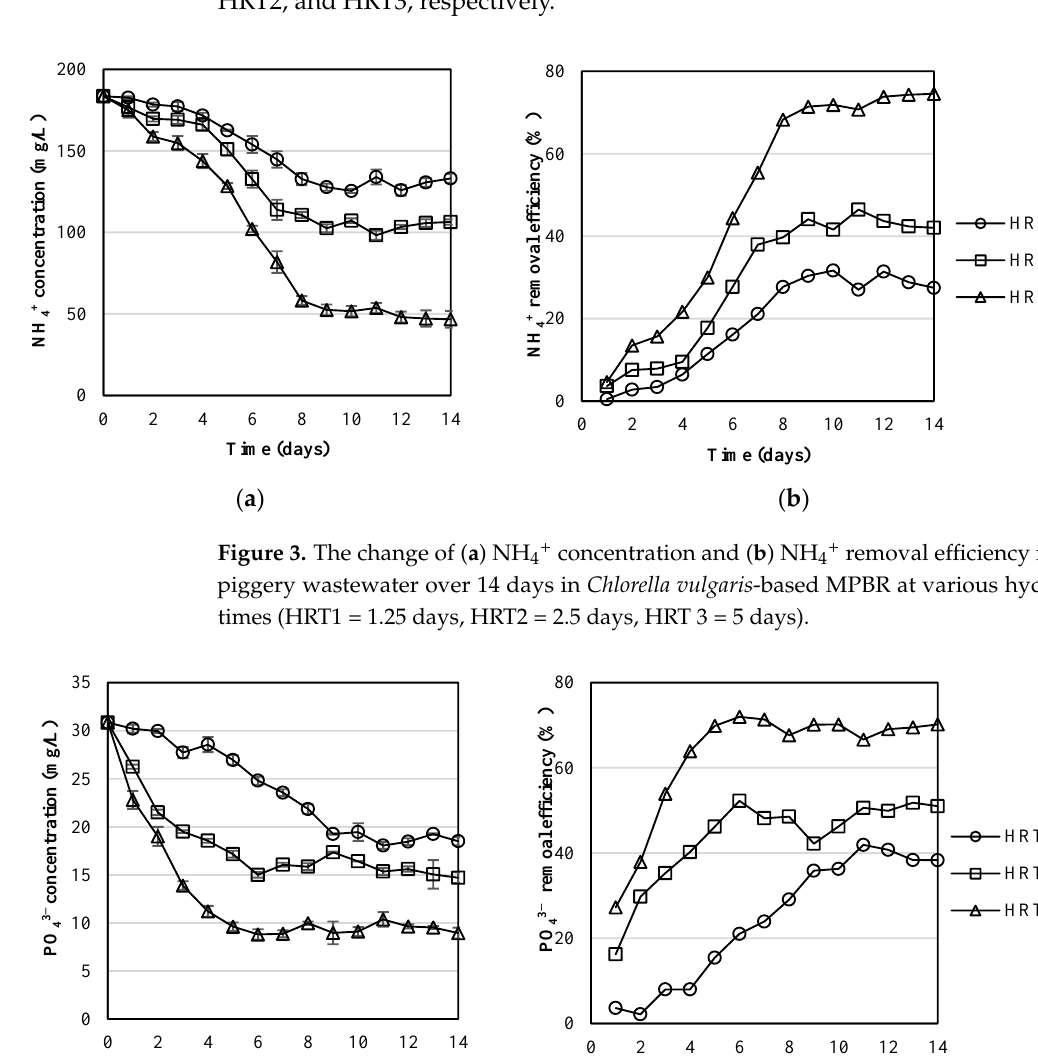
At the HRT2 of 2.5 days and HRT3 of 5 days, the PO 43 − concentration reduced significantly from 31 mg/L to 17.15 (46.19 %) and 9.61 mg/L (69.85%) from Day 0 to Day 5, respectively. At a shorter time of HRT1 (1.25 days), the decrease of PO 43 − was at a much slower pace, which was only 15.44% (31 mg/L to 26.95 mg/L) reduction on Day 5. After Day 9, the PO 43 − concentration was stable at 19.25 mg/L, 17.35 mg/L, and 8.97 mg/L for HRT1, HRT2, and HRT3, respectively.